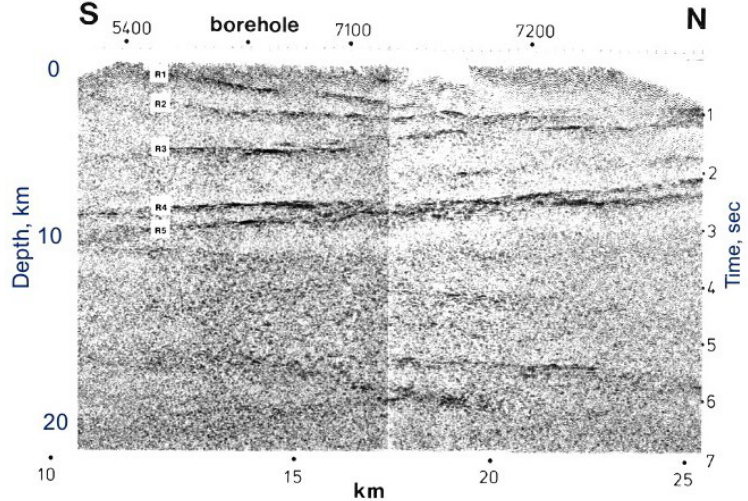
Figure 3. Strong subhorizontal reflections mapped in the upper 10 km of Proterozoic crust by seismic reflection profiling at the Siljan Ring Sweden [55]. Depth assuming the average velocity of 6 km/s. R1–R5 label individual reflectors in this stack.